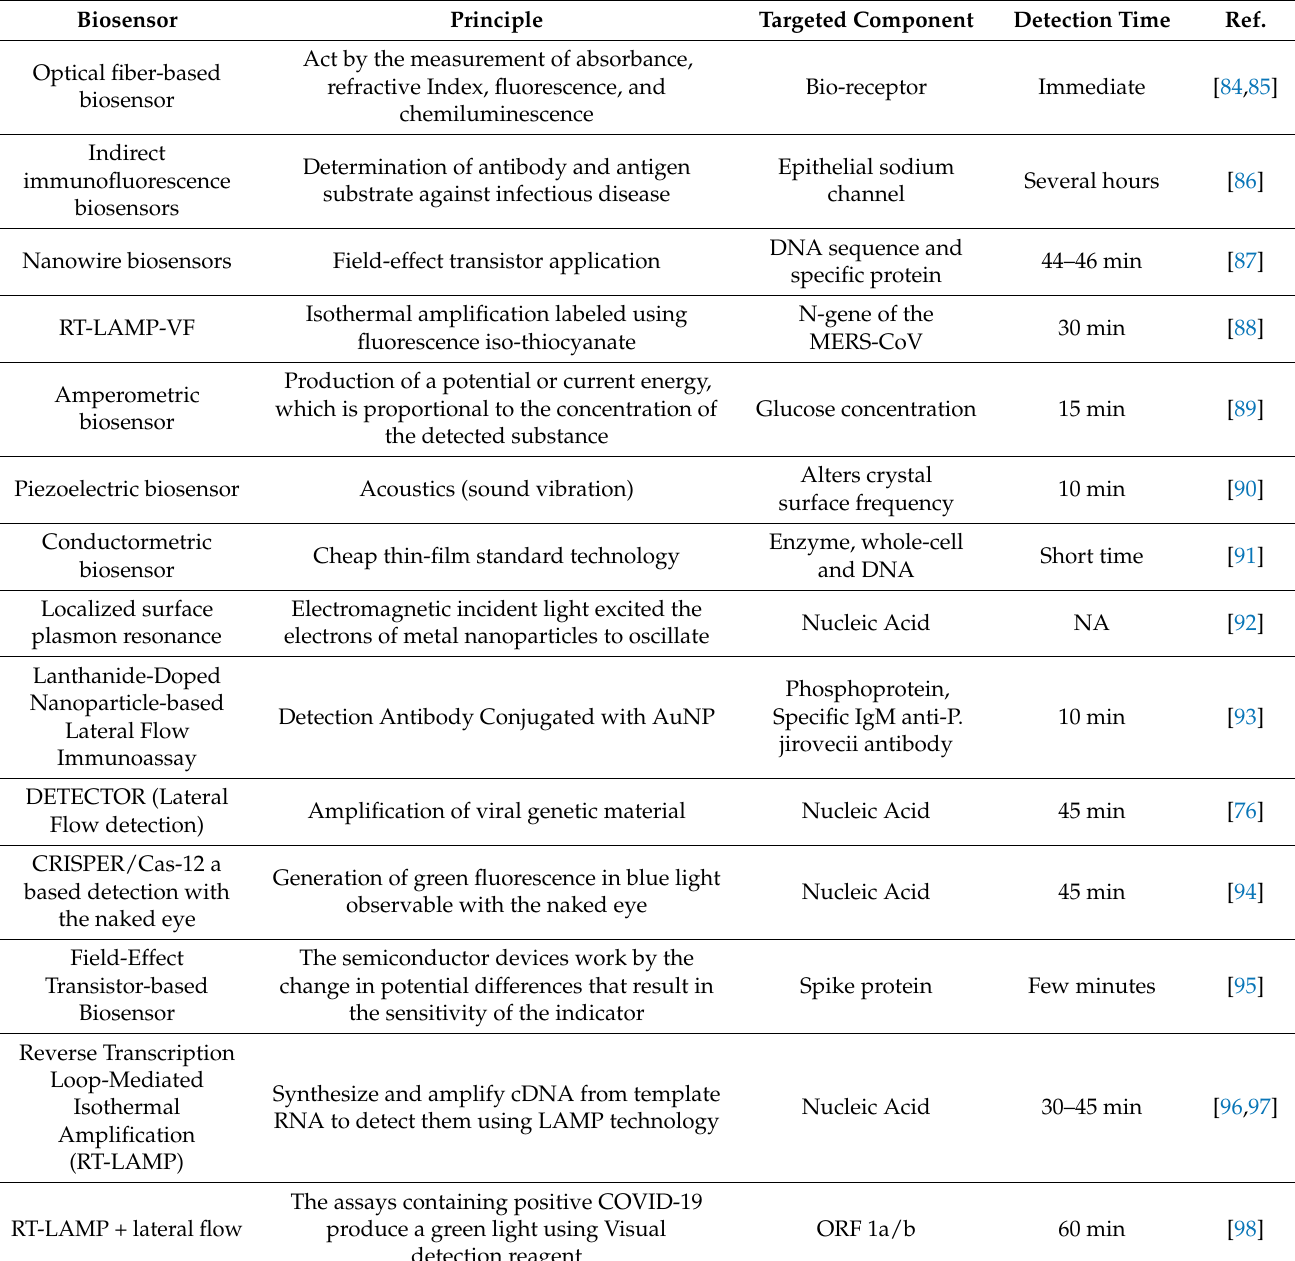
Table 2. Summary of various nanobiosensors for detection of SARS-CoV-2 and related